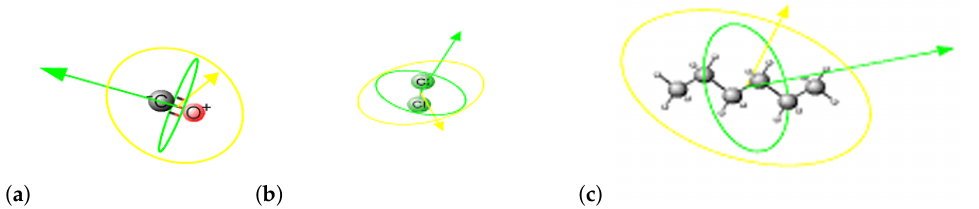
Figure 2. Possible spacial orientations of ( a ) carbon monoxide, ( b ) chlorine and ( c ) hexane whose range of molecular projection areas are (8.13–11.01), (9.62–16.70) and (21.59–40.59) angström,